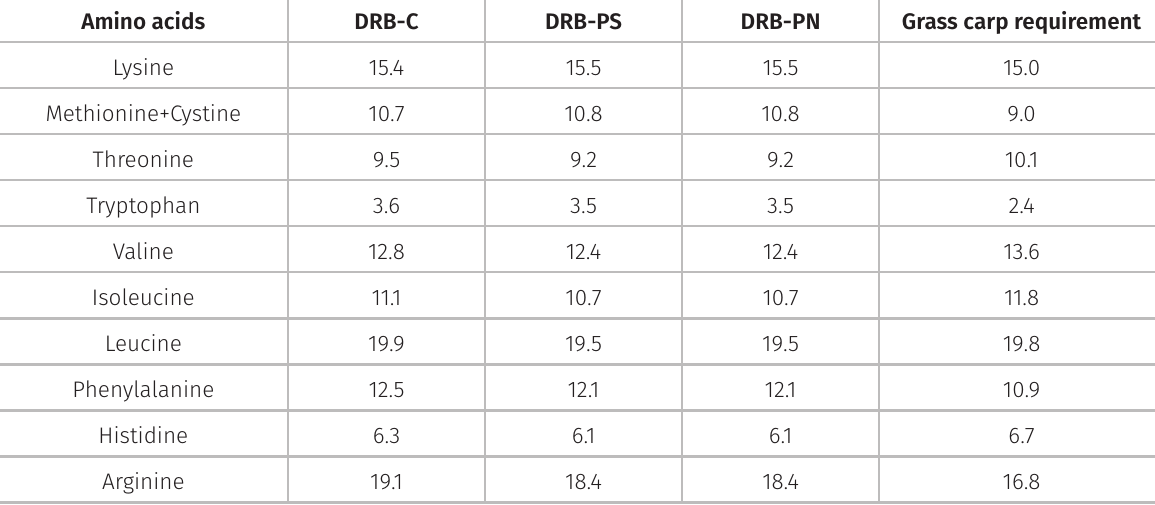
Table II. Composition of amino acids (g kg -1 ) of the experimental feeds. Amino acids